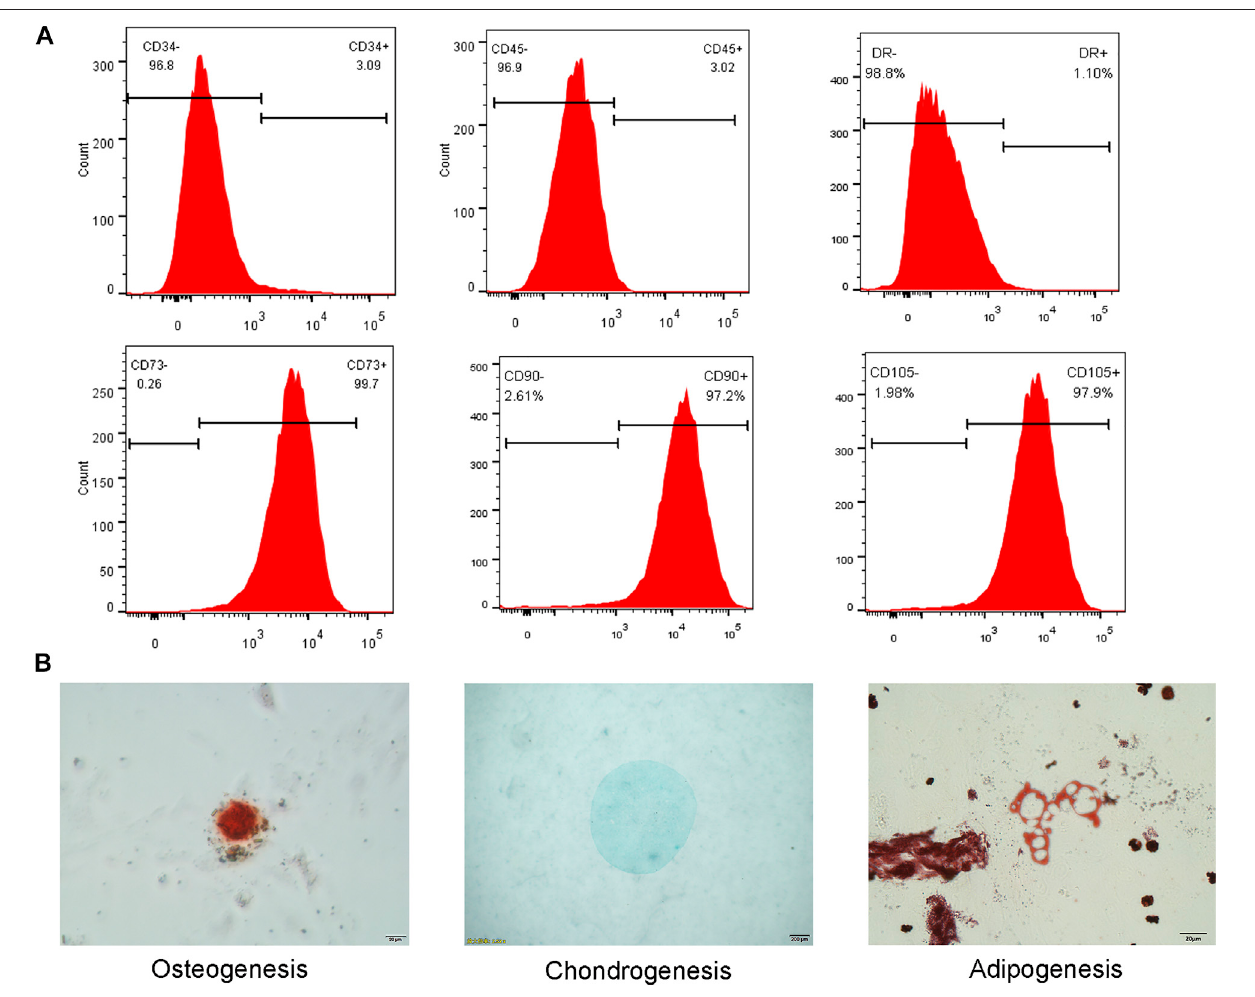
FIGURE 4 | (A) Flow cytometry analysis showed low expression of CD34, CD45 and HLA-DR, and high expression of CD73, CD90 and CD105. (B) Three lineage differentiation of hNPMSCs. Alizarin red staining of calcium nodules indicated osteogenic differentiation. Alcian blue staining of cartilage indicated chondrogenic differentiation. Oil red O staining of intracellular lipid vacuoles indicated adipogenic differentiation.